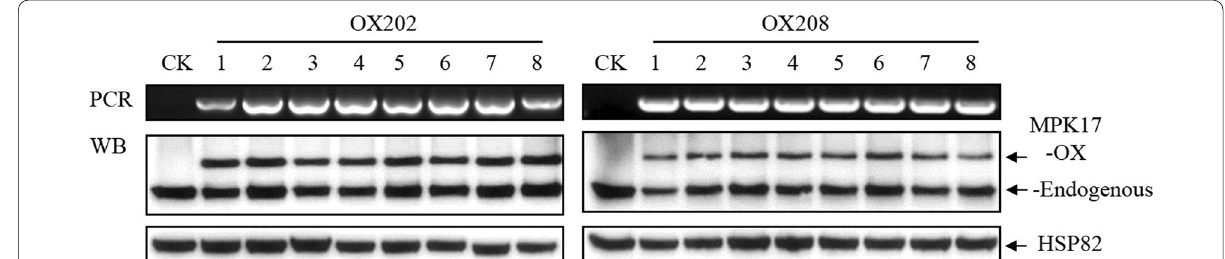
Fig. 4 Identification of MPK17-OX transgenic lines by PCR and WB. OX202 and OX208: independent MPK17-OX transgenic lines; CK: 4021 (homozygous TP309 transgenic line harboring the Xa21 gene); 1–8: individual transgenic plants in T 3 generation; PCR: PCR genotyping results done with primers (5’-GCG GTA CCA TGG GCG GCC GCG CCC GCTC-3’, 5’-GCG AGC TCG GTT TTC AGT TGA GCA AC-3’). MPK17-OX: the transgenic MPK17 protein;